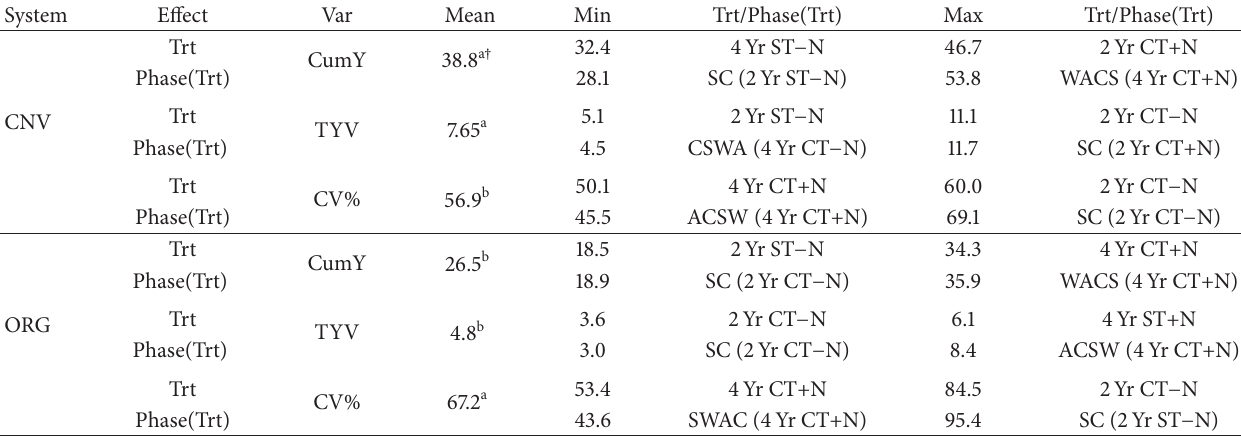
Table 1: Least squares means, minimum (Min) and maximum (Max) cumulative yield, CumY, (Mgha − 1 ), temporal yield variance, TYV, (Mgha − 1 ) 2 and coefficient of variation, CV% for treatments, Trt, and Phase within treatments, Phase(Trt), in conventional (CNV) and organic (ORG) cropping systems of a long-term experiment.